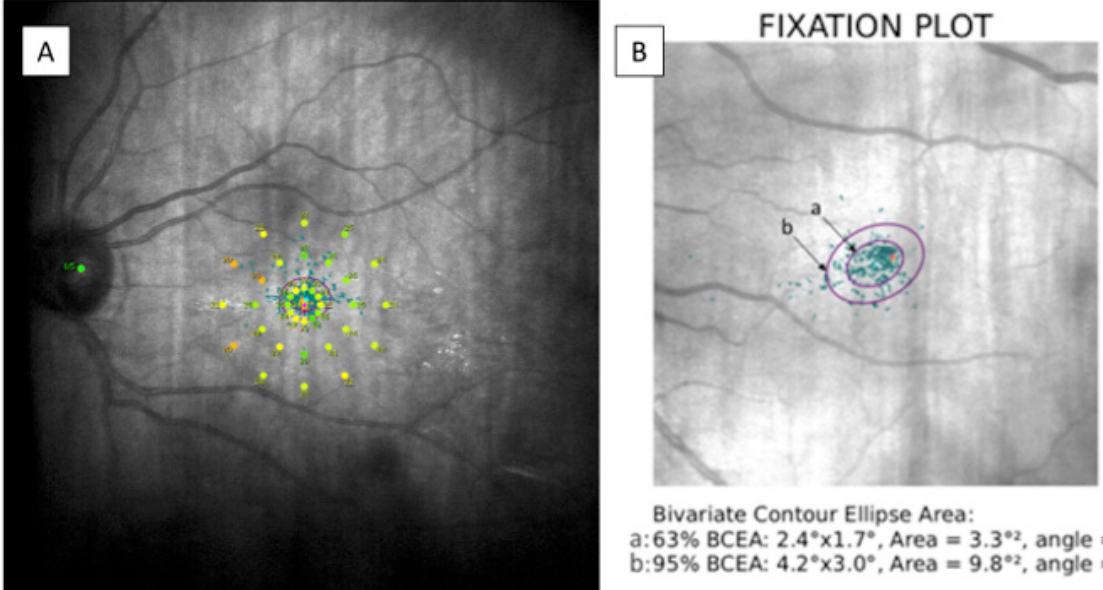
Figure 1. ( A ) Modified image provided by MAIA microperimetry showing the 37 sensitivity points on a color scale map. ( B ) BCEA data corresponding to a patient examined during the study. The BCEA corresponds to the area of two ellipses; “a” containing 63% (minor ellipse) and “b” containing 95% (major ellipse) of the fixation points. MAIA: macular integrity assessment, BCEA: bivariate contour ellipse area.